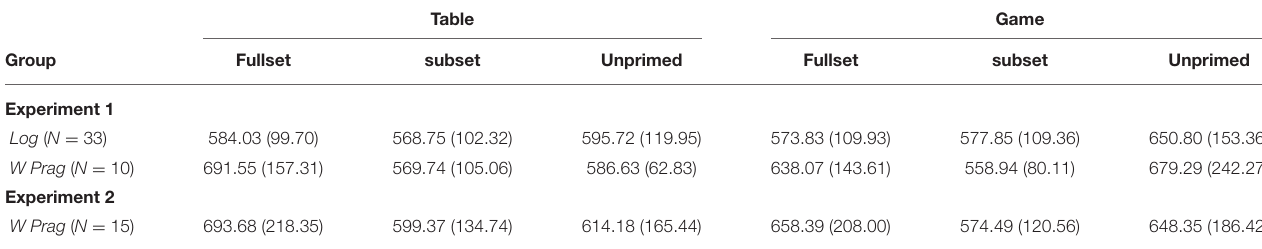
TABLE 4 | The mean response time (with SD) in ms after excluding missed, incorrect responses and outliers (condition mean ± 2 SD). Table